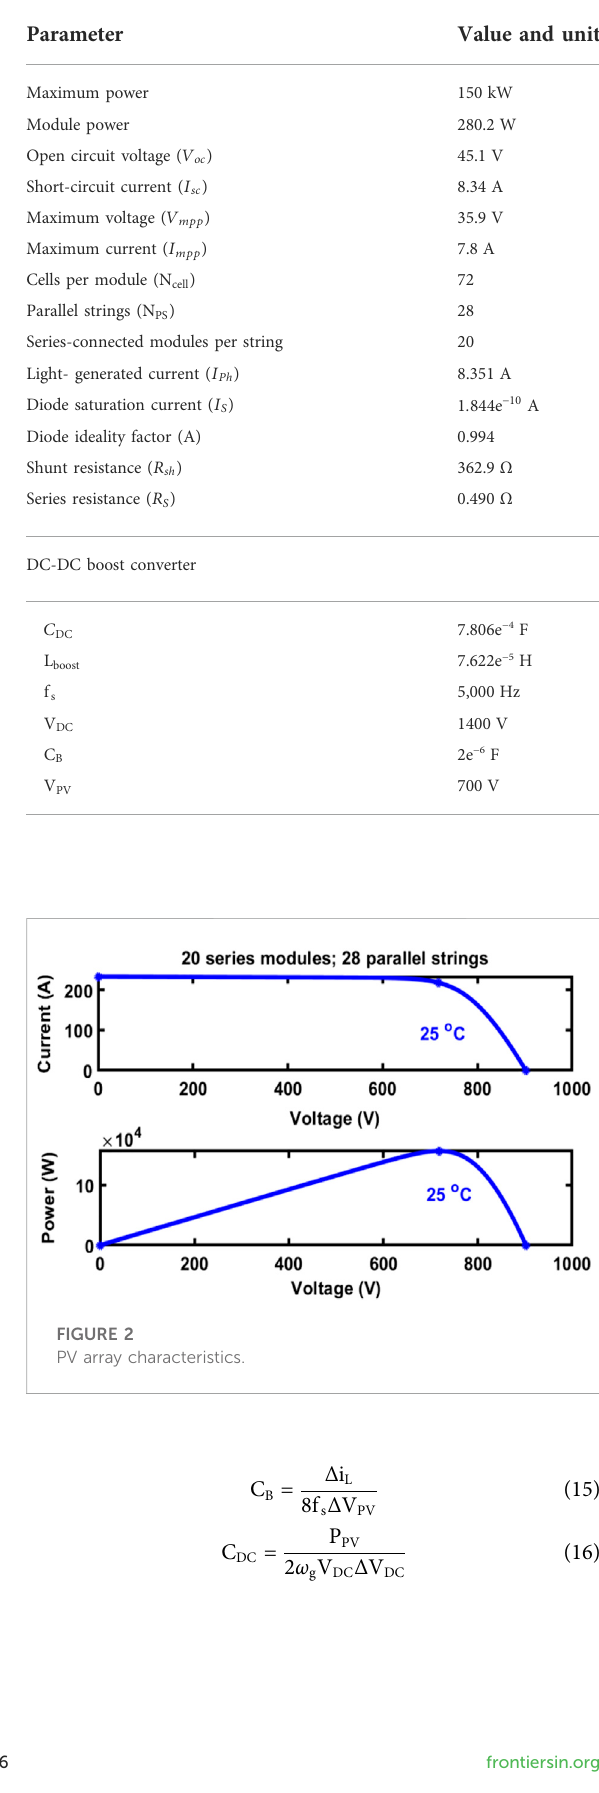
TABLE 1 PV system characteristics.